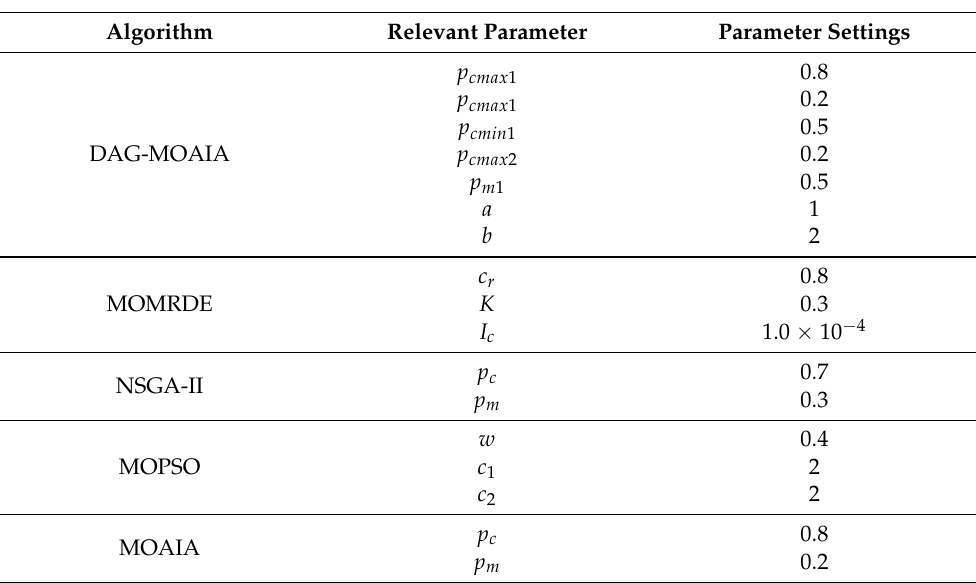
Table 3. Parameter settings of all